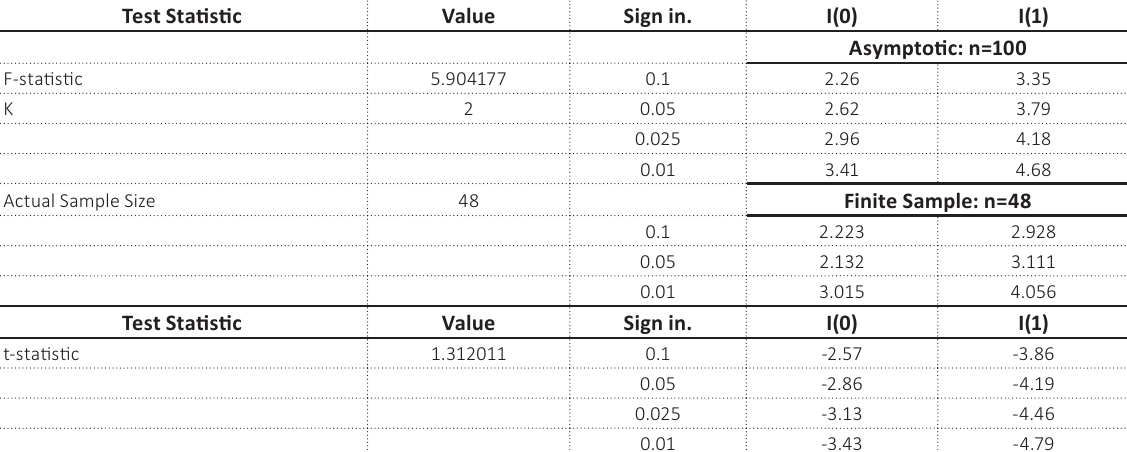
Source: Extracted from result